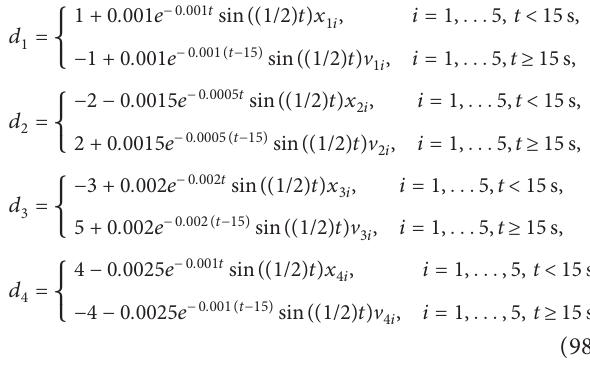
Figure 7: Comparison of real disturbance d